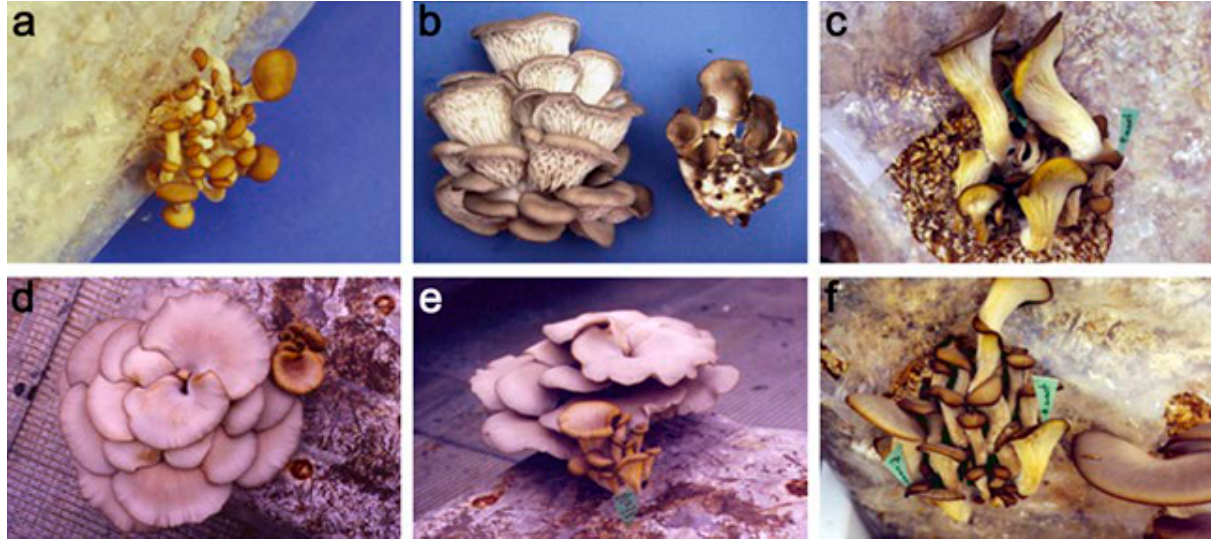
Figure 5. Pathogenicity assays on Pleurotus ostreatus whole sporocarps sprayed or injected into the stipe tissues with bacte- rial suspensions. Yellow-orange discolouration (a, c, d, e and f) or yellow-orange blotches (b) on sporocarp bunches of P. ostreatus and growth cessation after spray inoculation (a, b and c) or injection into stipe pseudo-tissues (d, e and f) with 10 8 cfu mL -1 bacterial suspensions of strains USB1, USB22 and NCPPB2192 of Pseudomonas tolaasii (a, b, d and e) and of strains USB6, USB20 and NCPPB1311 of P. ‘reactans’ (c and